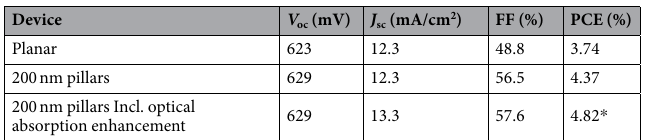
Table 2. Characteristics of the organic solar cell shown in Fig. 6b. * Overall PCE improvement (~28.5%) is due to better charge collection efficiency (~18%) and optical enhancement